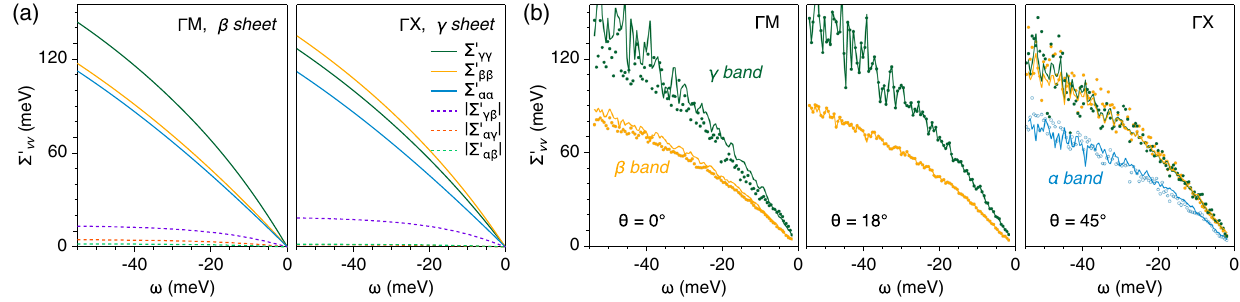
FIG. 13. Reconstructed self-energies in the quasiparticle basis. (a) Full matrix Σ 0 νν self-energy (shown in Fig. 6(a)) at two selected k points: on the β sheet for θ ¼ 0 ° (left) and on the γ sheet for θ ¼ 45 ° (right). ω Þ (solid symbols) (Sec. VA) compared to the Σ 0 (b) Directly extracted Σ 0 νν ð ω ; k ν max Σ 0 ω ; k ν ω Þ at 0, 18, and 45° (thin νν ð max